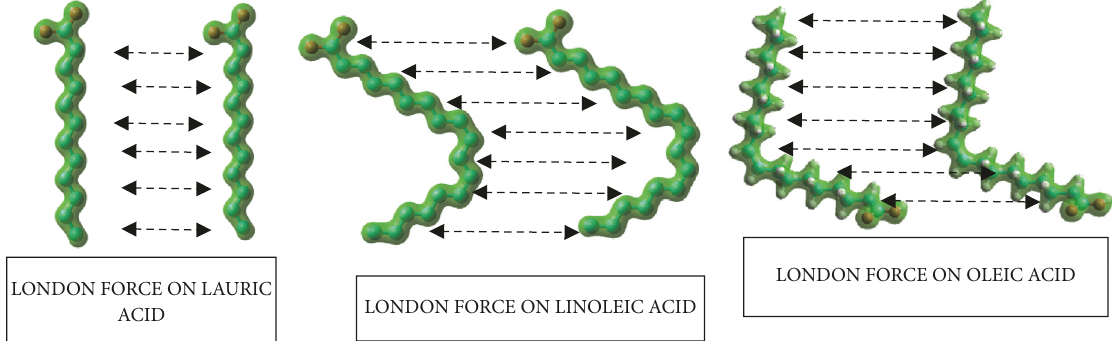
Figure 8: London force on lauric acid, linoleic acid, and oleic